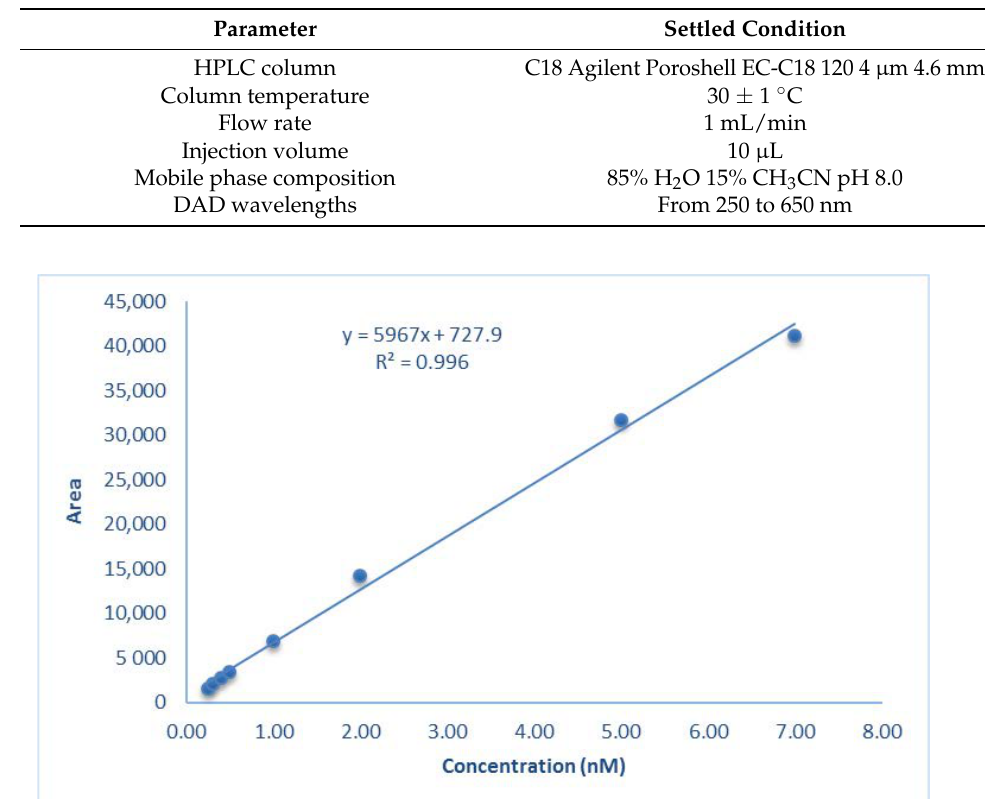
Figure 8. Calibration curve for mCP at λ 434 nm .